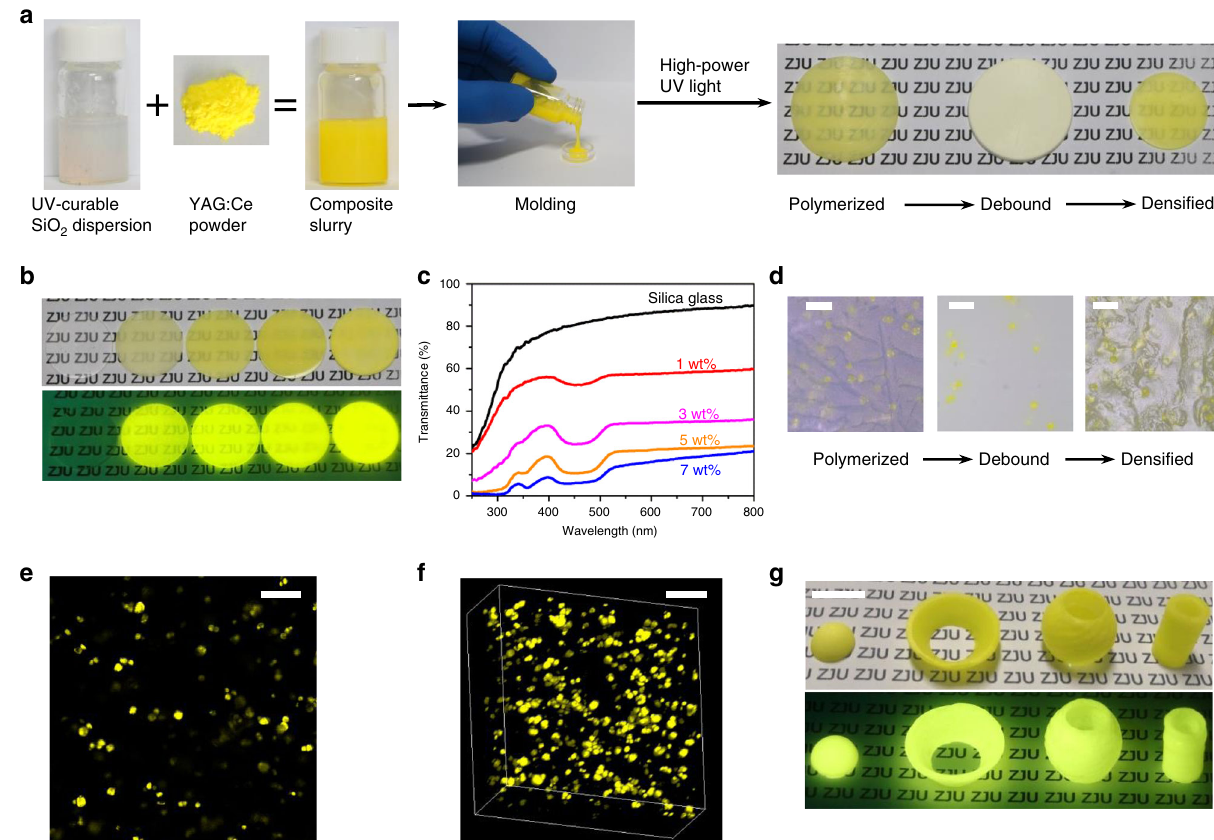
Fig. 1 Fabrication of YAG:Ce-PiSG. a Amorphous silica nanoparticles are fi rst dispersed into UV-curable monomer, and then YAG:Ce powders are mixed with the UV-curable dispersion to form the slurry, which is put into the mould and polymerized into fl at discs under high-power 365 nm light. After debound and sintered, they are fully densi fi ed into bulk composite (1.8 cm in diameter). Note that the resultant slurry shows no obvious phosphor settlement after siting for 30 min. b Flat discs of YAG:Ce-PiSG with various YAG:Ce contents (from left to right: 0, 1, 3, 5 and 7wt%, 1.8cm in diameter and 1.0 mm in thickness). c Total transmittance of YAG:Ce-PiSG with various YAG:Ce contents (1.0 mm in thickness). d Fluorescence microscope images of YAG:Ce/silica composite after polymerized, debound and densi fi ed (scale bar, 100 μ m). e Surface CLSM image of 3 wt% YAG:Ce-PiSG (scale bar, 100 μ m). f 3D reconstruction CLSM image of 3 wt% YAG:Ce-PiSG (scale bar, 100 μ m). g Examples of printed and sintered 3 wt% YAG:Ce-PiSG (scale bar, 1